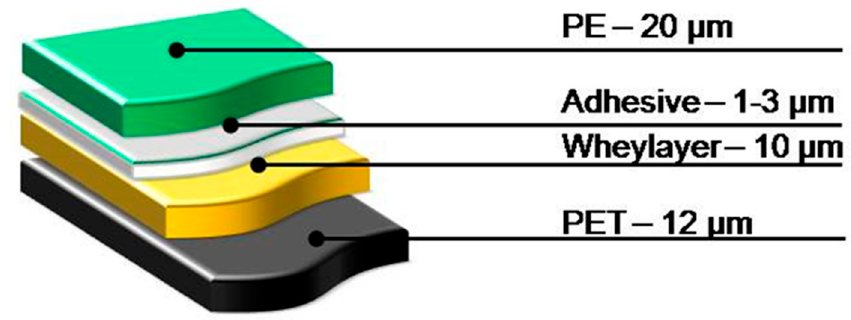
Figure 3. Composition of multilayer film with a whey protein-based barrier layer.